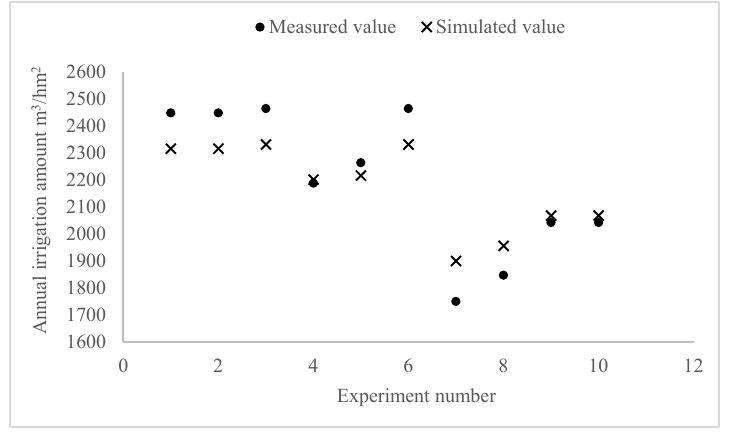
Figure 4. Verification of water balance model in Lycium barbarum active root layer.